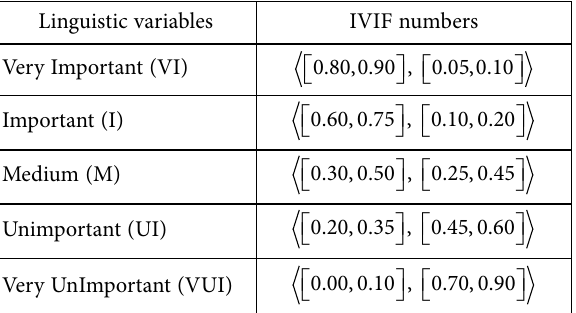
Table 1. Linguistic variables to express weights of DMs